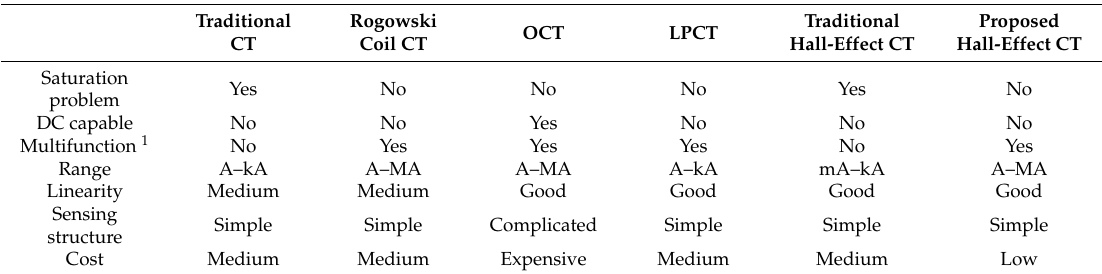
Table 1. Summary of the main current sensing